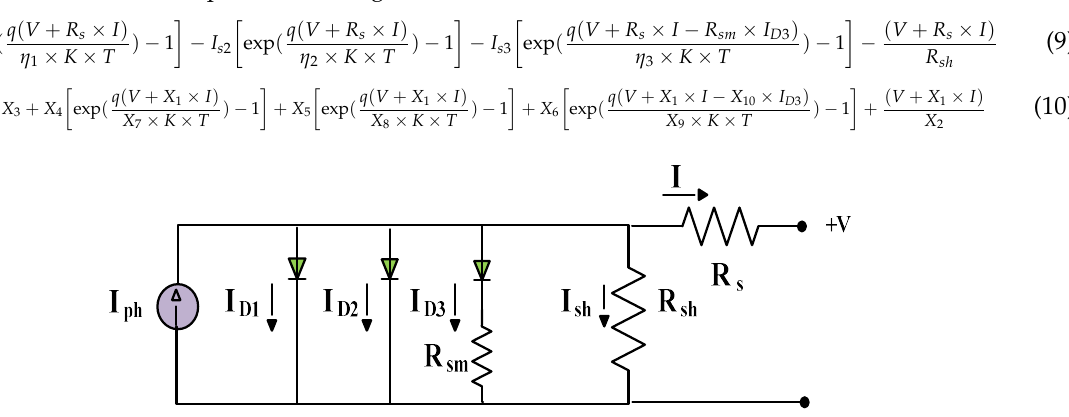
Figure 4. MTDM. Figure 3. TDM.